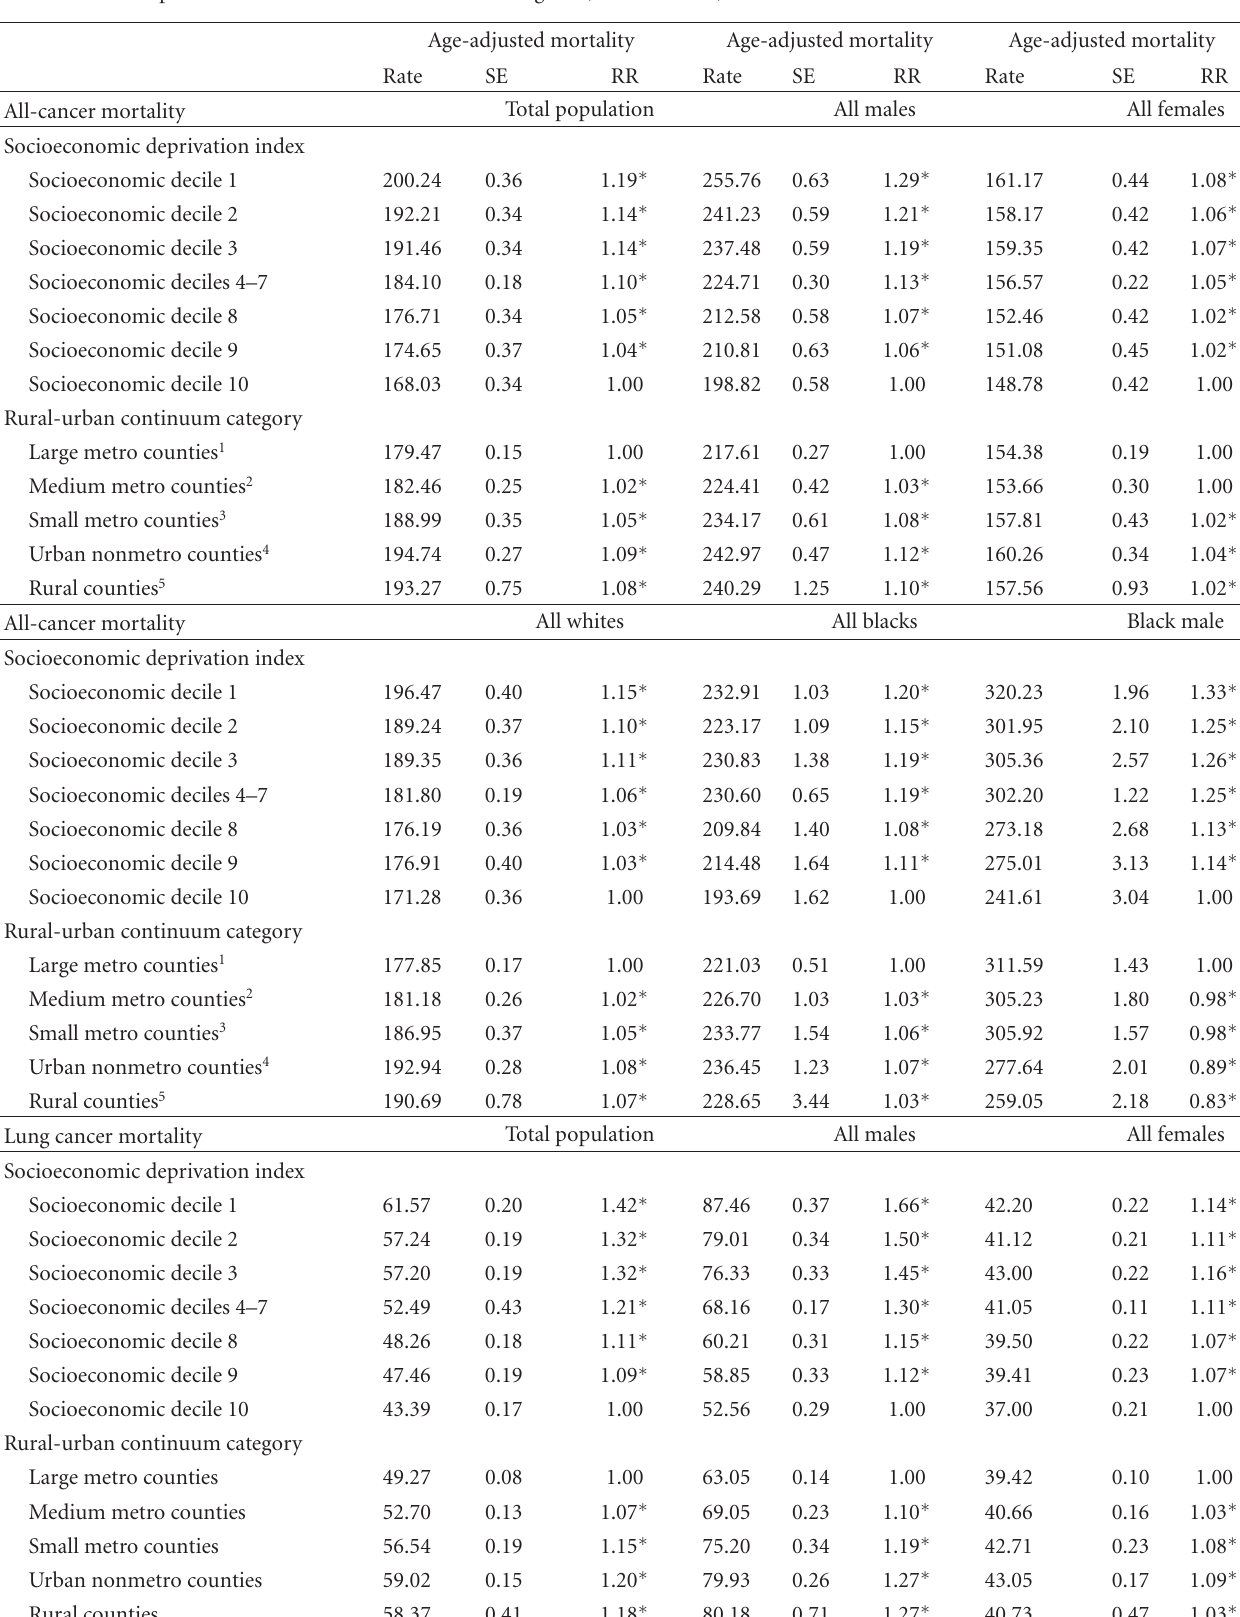
Table 1: Age-adjusted all-cancer and lung cancer mortality rates per 100,000 population and relative risk (RR) of mortality according to socioeconomic deprivation deciles and five rural-urban categories, United States,